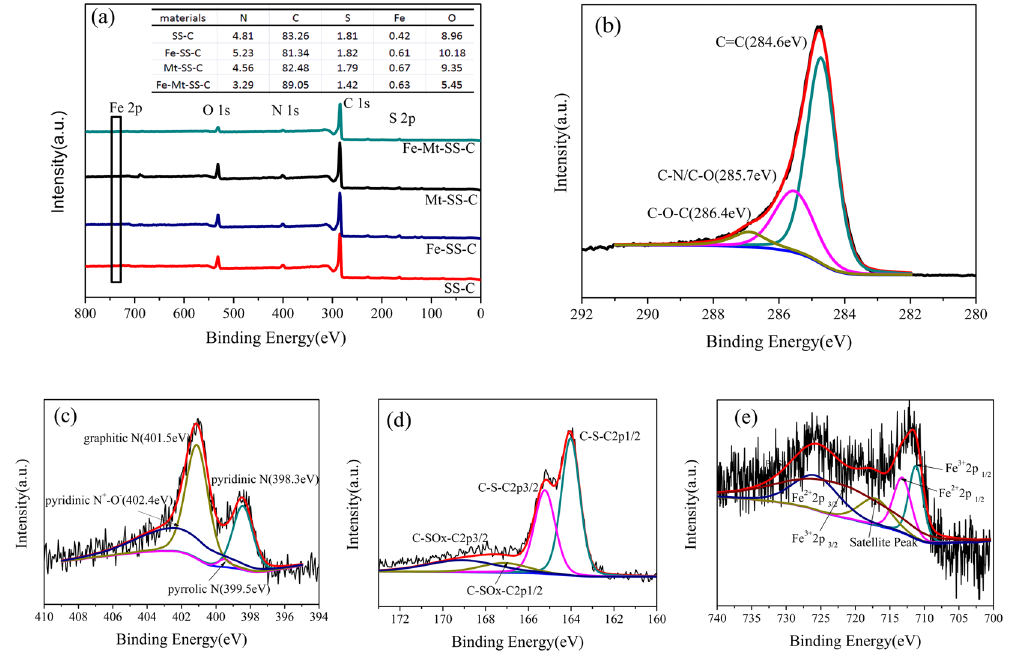
Figure 5. ( a ) XPS survey of SS-C, Fe-SS-C, Mt-SS-C, Fe-Mt-SS-C and ( b – e ) high-resolution spectra of C, N, S and Fe in